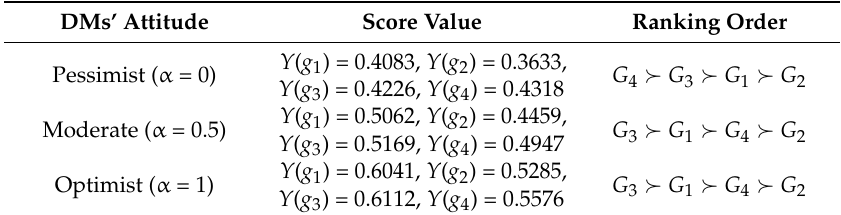
Decision results corresponding to the SVLN-ILN weighted geometric averaging (SVLN-ILNWGA) operator and the DMs’